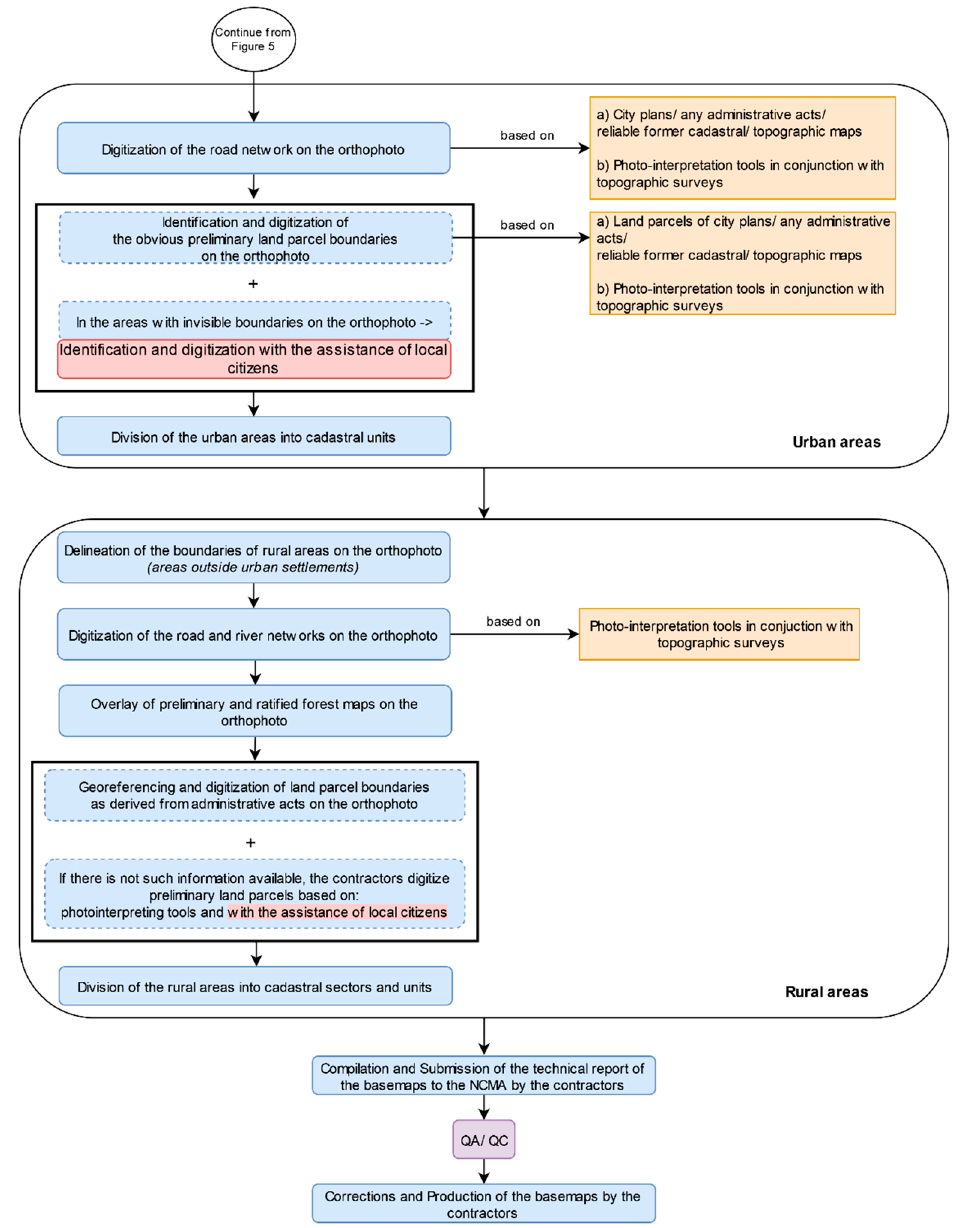
Figure 15. Procedure for the compilation of the draft cadastral basemap for urban and rural areas: NMCA’s actions (purple); contractors’ actions (blue); volunteers’ actions (pink).